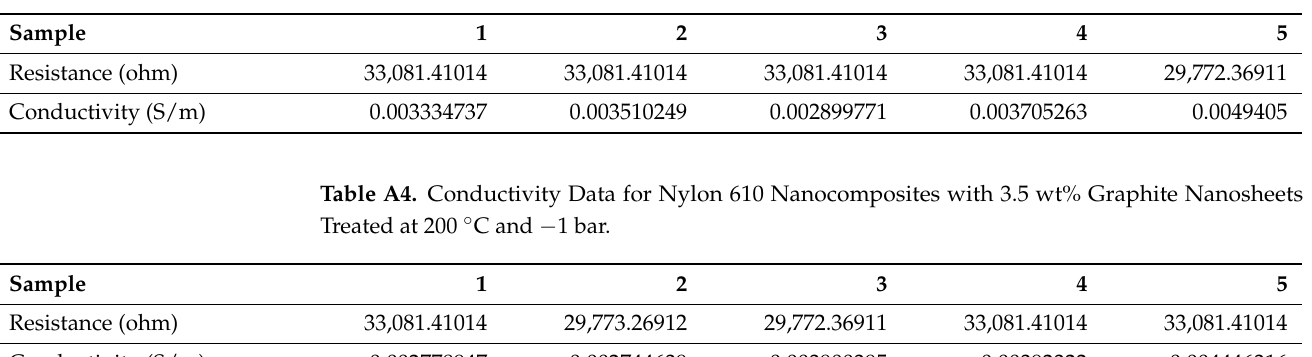
Table A3. Conductivity Data for Nylon 610 Nanocomposites with 2.5 wt% Graphite Nanosheets Treated at 200 ◦ C and − 1 bar.